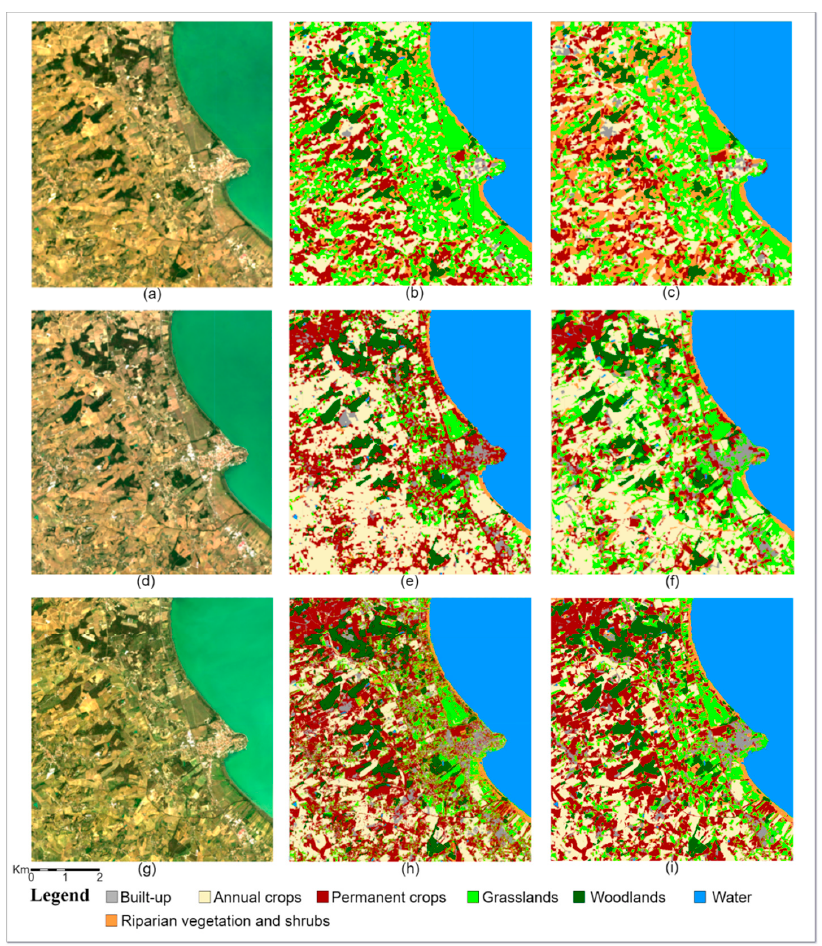
Figure 3. RGB image, pixel-based (PB), and object-oriented (OO) Land Use–Land Cover (LULC) classifications of the study-area. ( a ) RGB image, ( b ) PB, ( c ) OO for Landsat 8; ( d ) RGB image, ( e ) PB, ( f ) OO for Sentinel 2; ( g ) RGB image, ( h ) PB, ( i ) OO for PlanetScope.